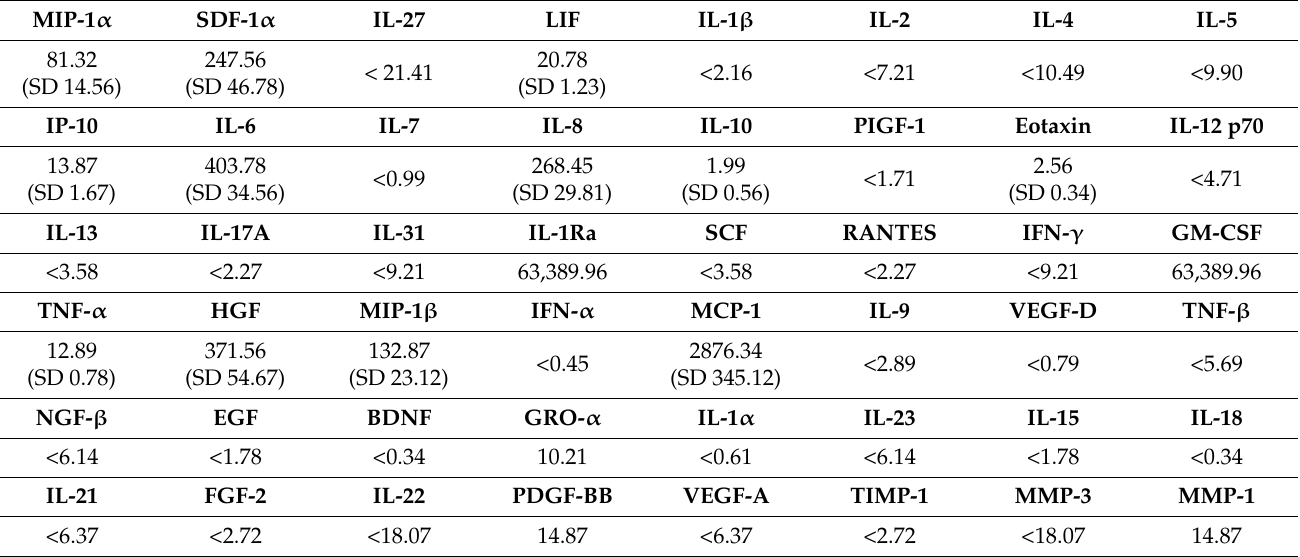
Table 5. Mean values of the molecules studied. Values are shown in picograms per